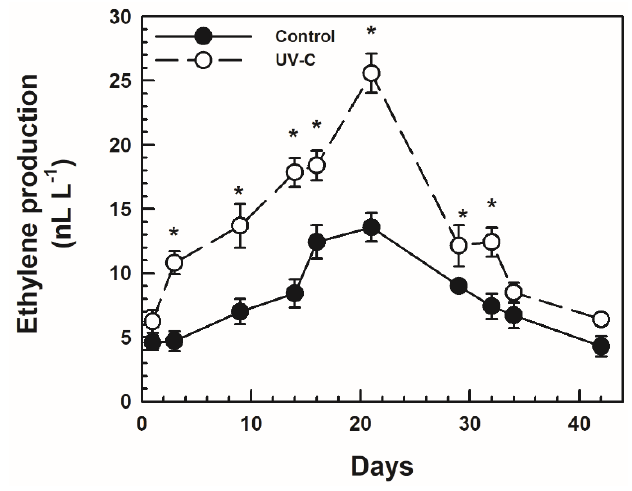
Figure 2. Ethylene production (nL L − 1 ) of P. × hortorum stem cuttings irradiated with 1 kJ m − 2 or left nonirradiated (controls) over a 6-week period. Data ( n = 15) are means per treatment per day ±S.E. Asterisks indicate significant differences between treatment means at p = 0.05.